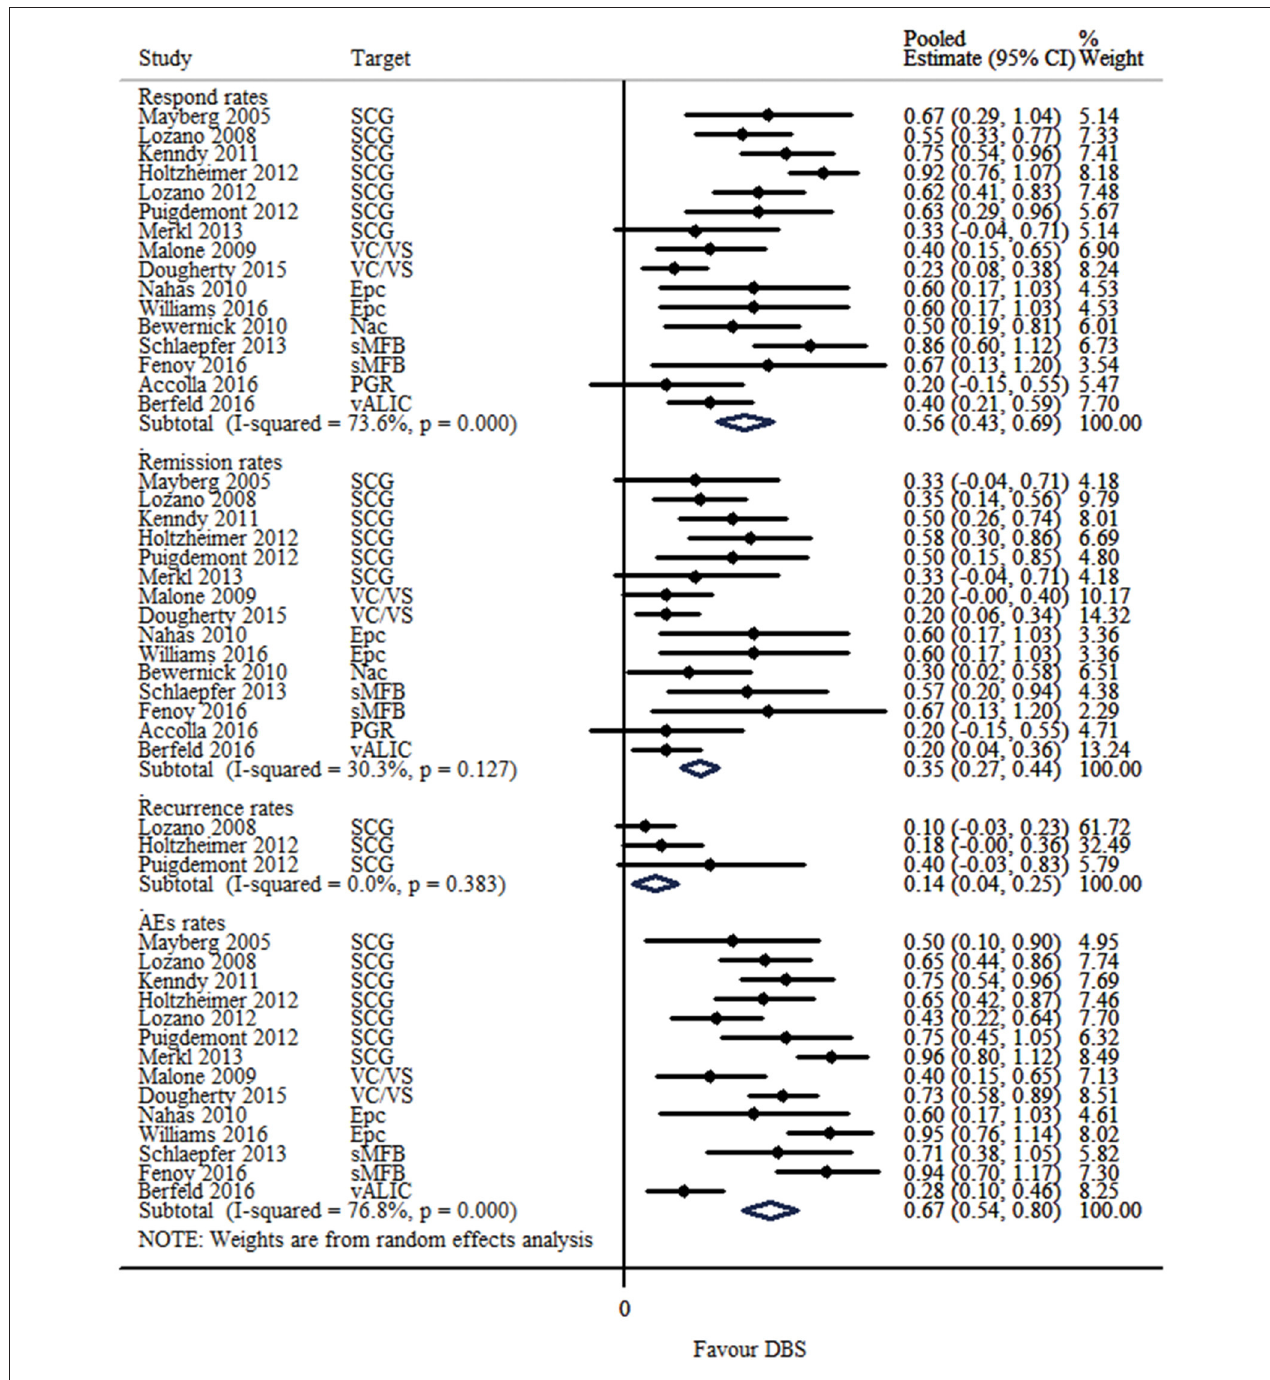
FIGURE 2 | Forest plots showing a summary of evaluation of respond, remission, recurrence and AEs rates in the open-label